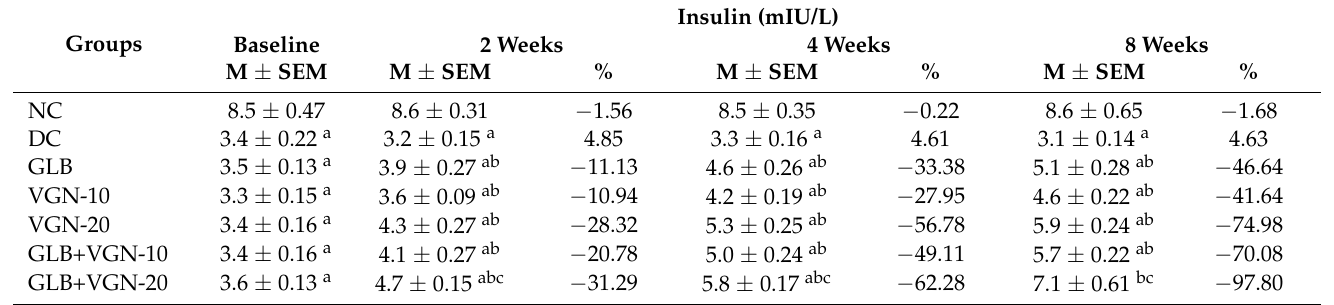
Table 2. Effect of GLB, VGN and their combinations on insulin levels in blood of STZ-induced rats.